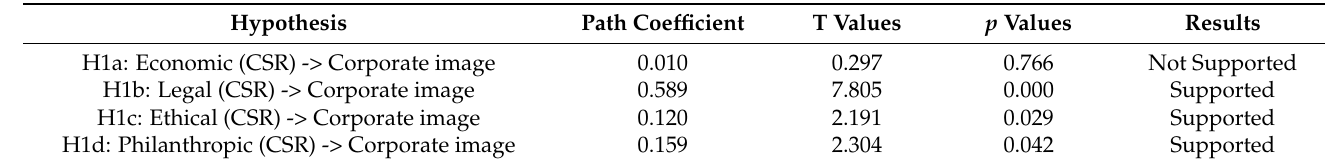
Table 3. Hypotheses results for model A.